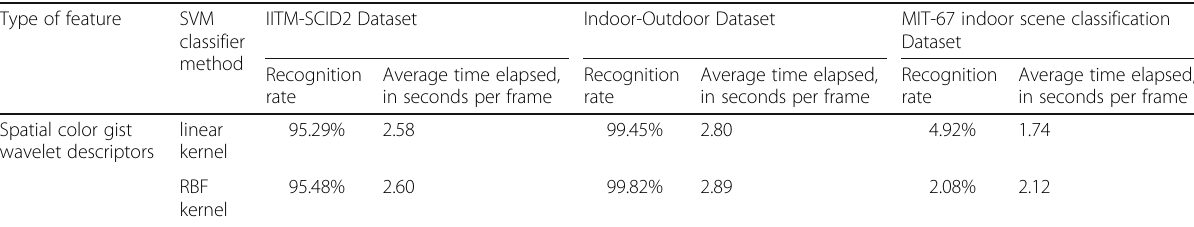
Table 3 Computational cost calculation Type of